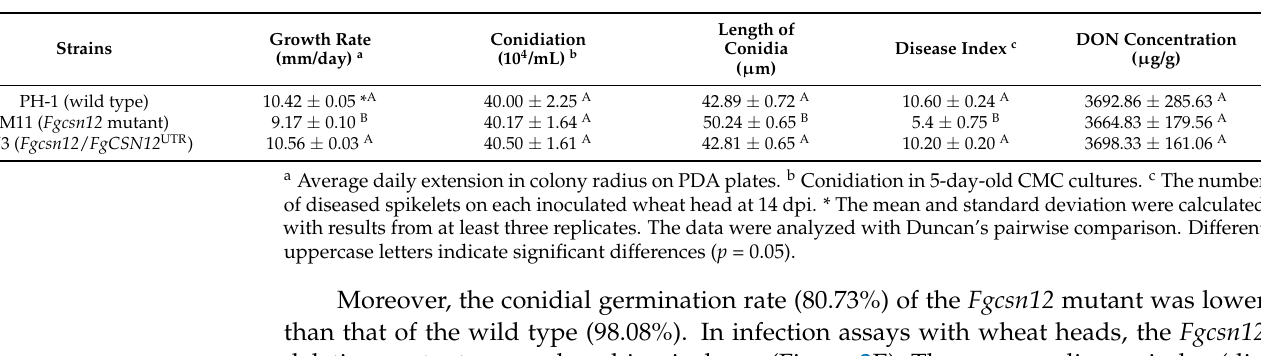
Figure 2. Defects of the Fgcsn12 mutant in vegetative growth, conidial morphology, and pathogenicity. ( A ) Three-day-old PDA cultures of the wild type (PH-1) and Fgcsn12 mutant (M11). ( B ) Growth rate of the indicated strains based on data from three biological replicates. ( C ) Conidial morphology of the indicated strains. Bar = 10 μ m. ( D ) The average conidia length was calculated with data from 100 conidia. ( E ) Representative images of wheat heads infected with the indicated strains were photographed at 14 dpi. Black dots mark the inoculated spikelet. ( F ) The disease index of the indicated strains was estimated with data from five independent biological replicates. ( G ) DON levels in diseased wheat spikelets inoculated with the indicated strains based on data from three biological replicates. * Indicates significant differences based on t -test analysis followed by Duncan’s multiple range test ( p = 0.05). Table 2. The growth rate, conidiation, length of conidia, and virulence of the Fgcsn12 mutant.